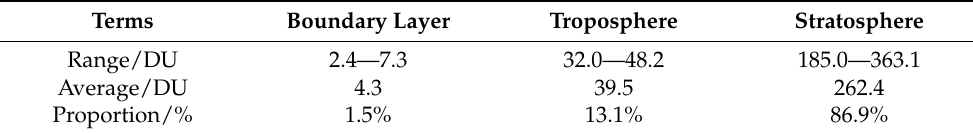
Table 2. The column burdens and proportions of ozone in different layers at the Shaowu station in the winter of